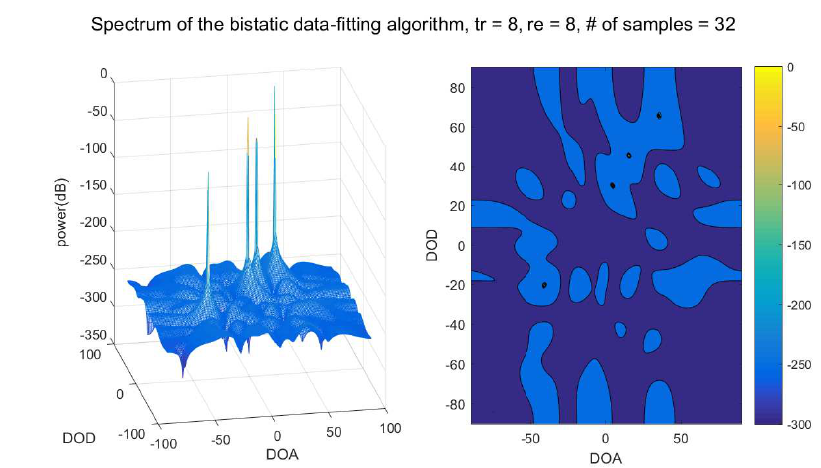
Figure 7. Spectrum of the bistatic data fitting algorithm, the number of targets = 4 (case